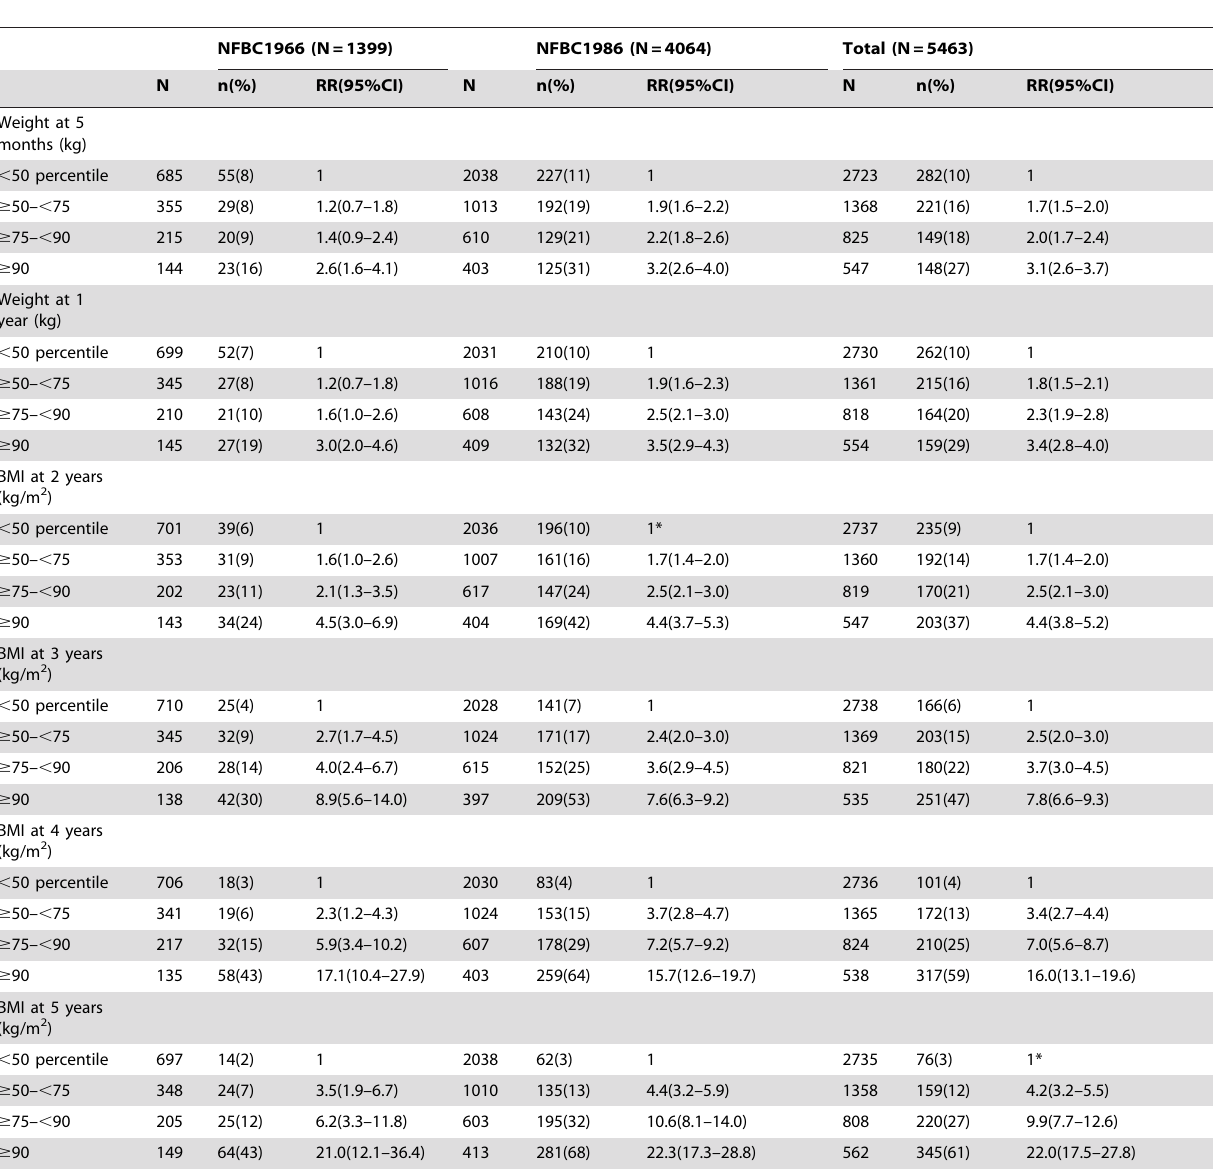
Table 2. Relative risk of overweight at the age of 9 years according to the IOTF associated with early weight and BMI measures in the NFBCC1966 and the